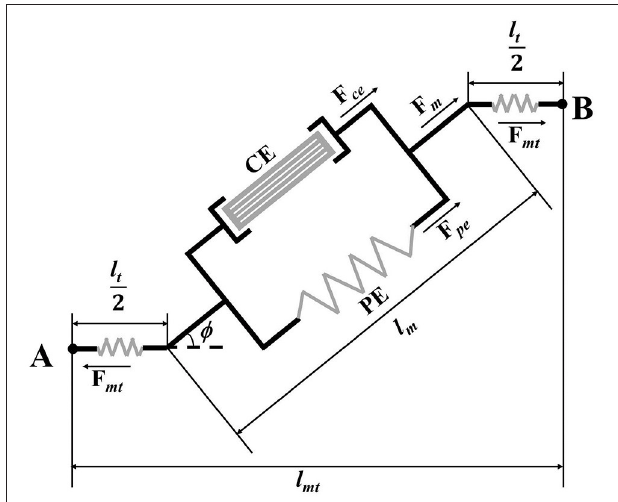
FIGURE 2 | Schematic of Hill-based muscle-tendon model.